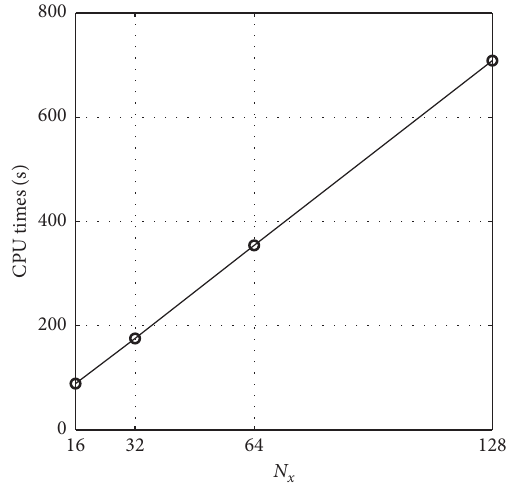
Figure 2: CPU times versus spatial step.